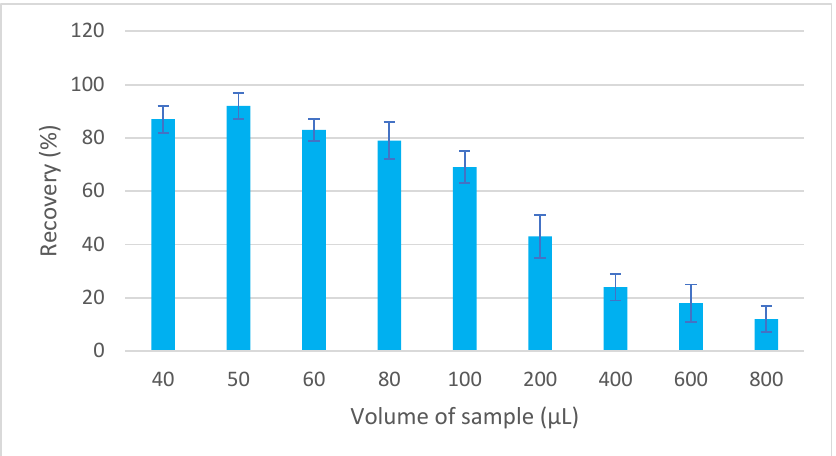
Figure 2. Dependence of recovery of EGDN on sample volume.